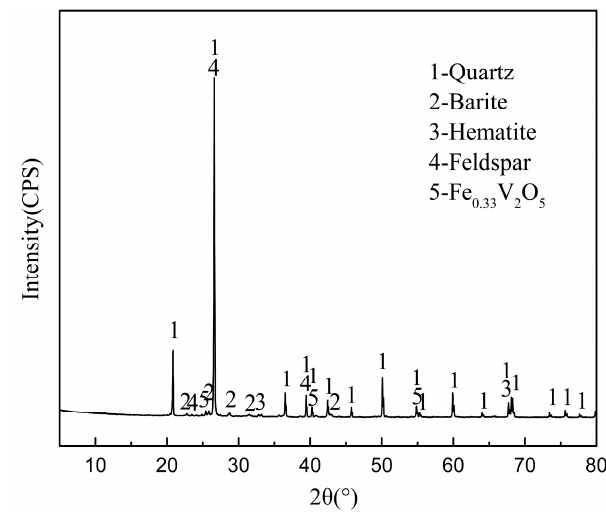
Figure 1. X-ray diffraction (XRD) image of the ore sample.